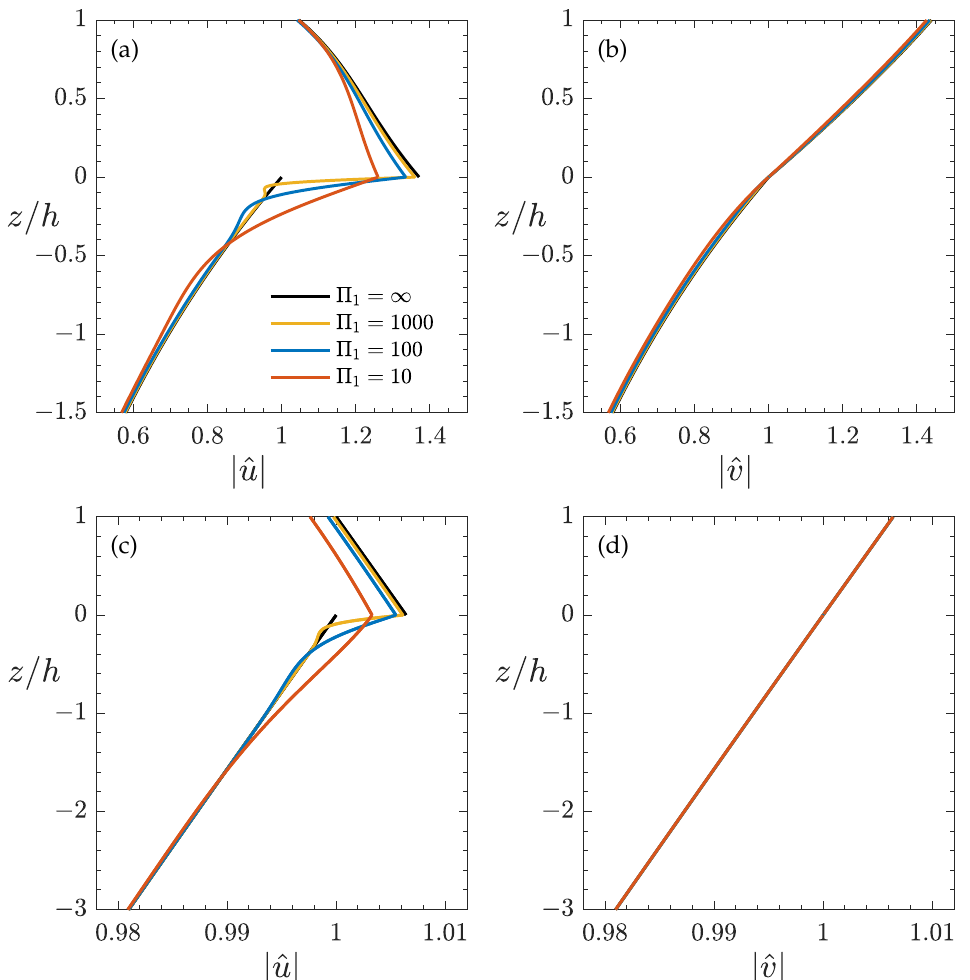
Figure 7. Velocity amplitudes WBL in water under the ice: ( a , b ) ˜ ω = 0.6, ( c , d ) ˜ ω = 0.08.